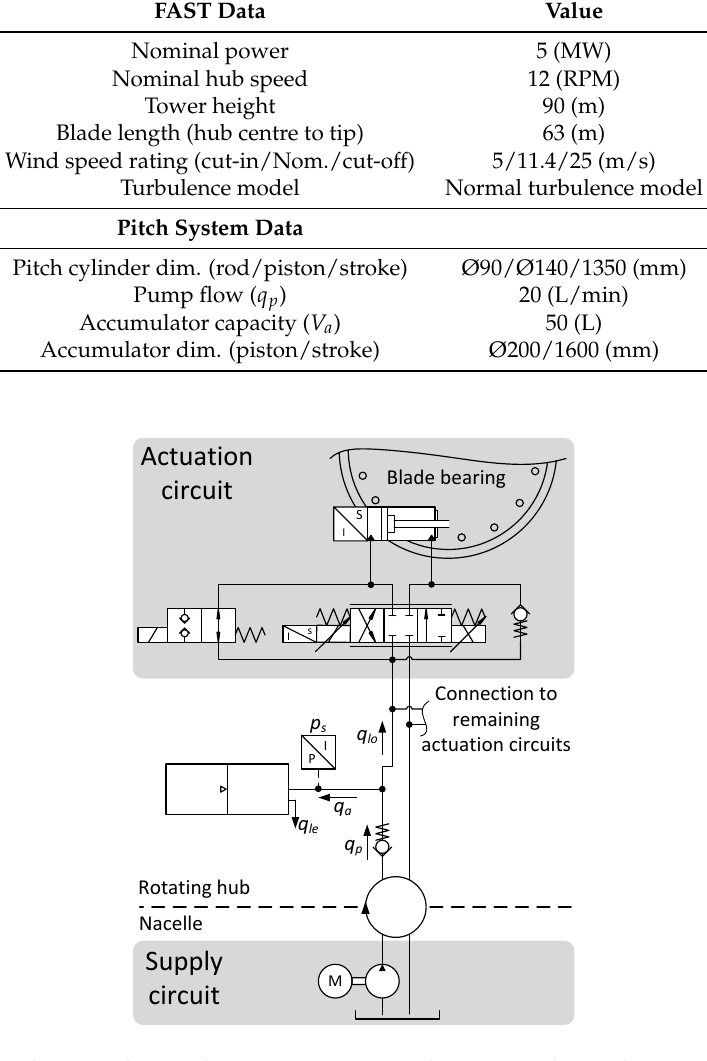
Figure 1. Pitch system layout showing common supply circuit and a single actuation